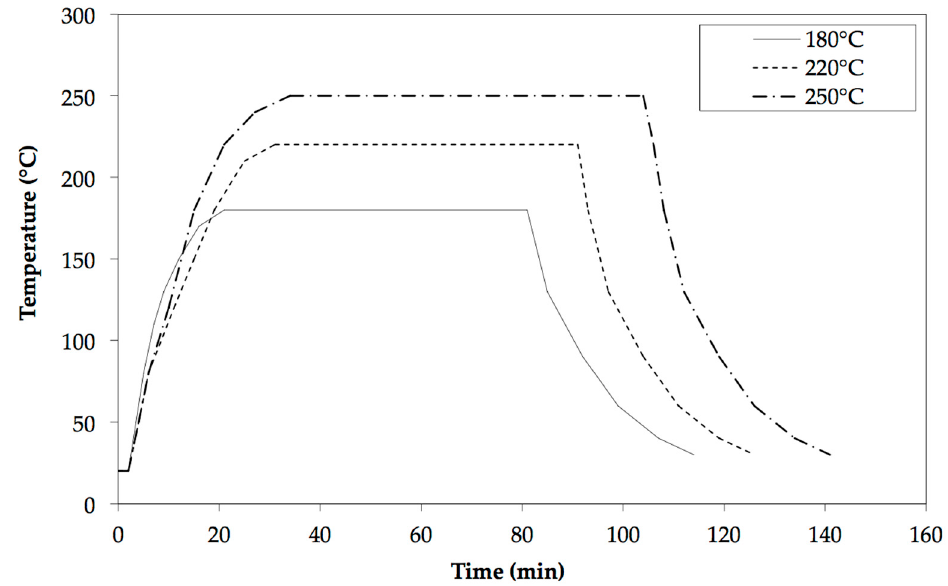
Figure 1. Typical trends of temperature during hydrothermal carbonization (HTC) runs performed at 180, 220, and 250 °C.